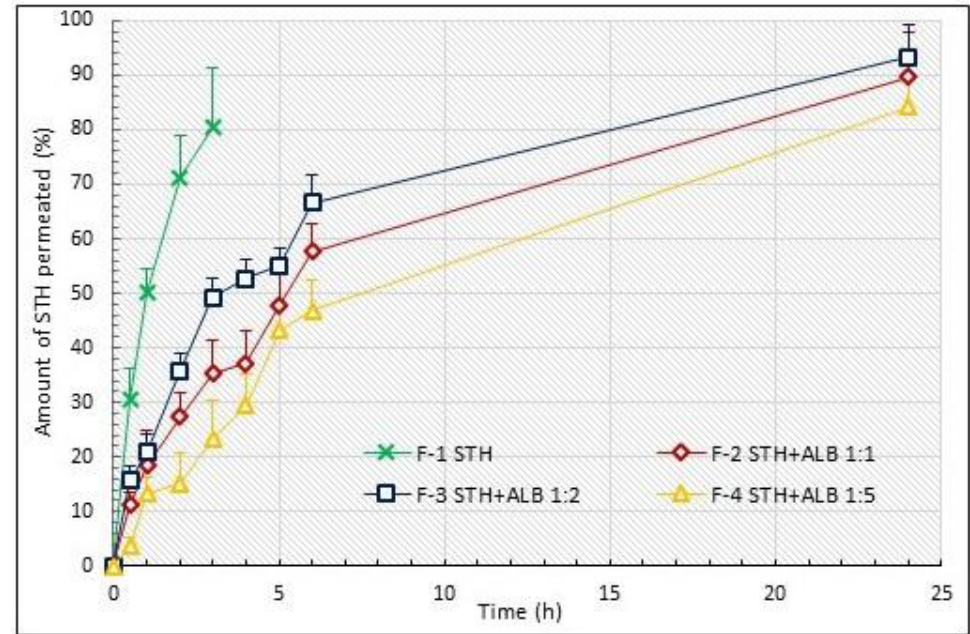
Figure 2. Permeation of STH through porcine skin at 24 h; F-1 — STH 0.1%, F-2 — STH /ALB 1:1 (0.1%:0.1%), F-3 — STH /ALB 1:2 (0.1%:0.2%), F-4 — STH /ALB 1:5 (0.1%:0.5%), n = 6.